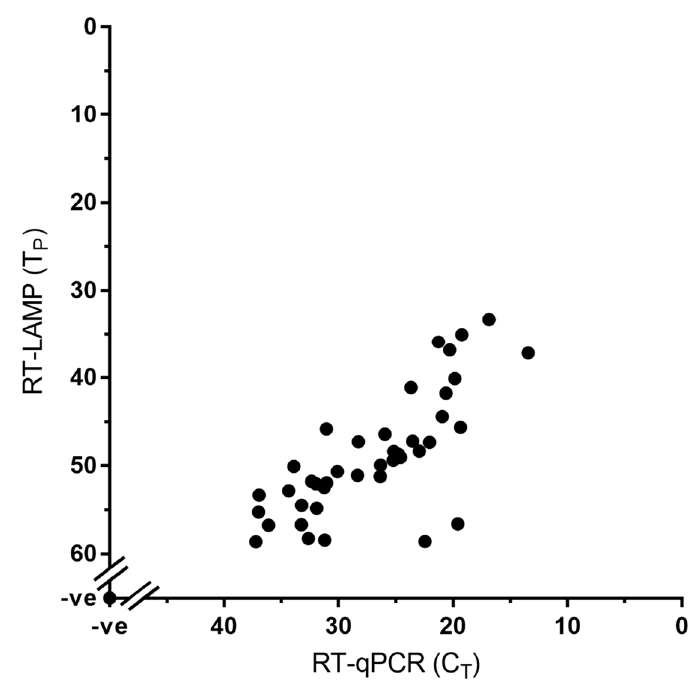
Figure 3. Diagnostic sensitivity of the RT-LAMP assay showing 100% concordance with the RT-qPCR assay. A total of 68 samples were used in this assay; the 41 positive samples (33 clinical samples and eight cell culture grown PPRVs) are shown in the graph whereas the 27 negative samples are represented by a single dot at the intercept of the x- and y-axis.